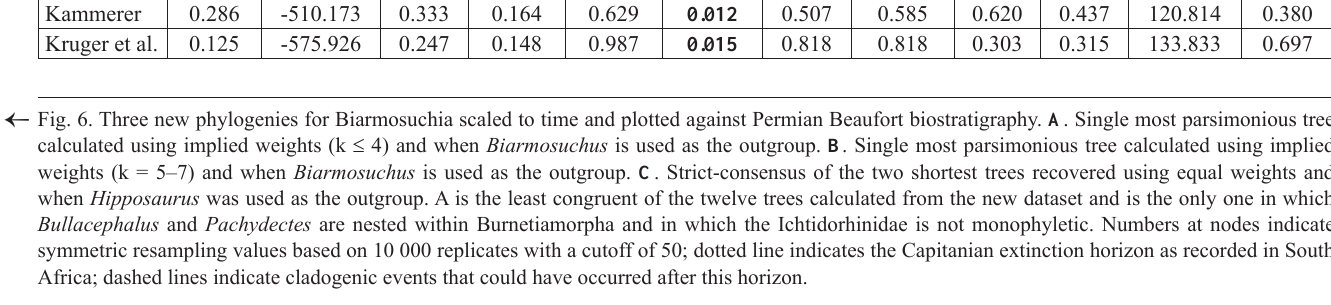
Table 1. Comparison of stratigraphic congruence metrics for trees shown in Fig. 6 (new trees A–C) and Fig. 7. P-values for individual metrics calculated from 1000 randomly constructed trees bearing the same end taxa. The new trees are better fitted to stratigraphy for all metrics and are the only one sig- nificantly different from random for the GER and MSM*. Bold indicates that a stratigraphic congruence metric is significantly different from random at p = 0.05 or p = 0.01. Abbreviations: GER, gap excess ratio; GER*, modified GER; GERt, topological GER; MIG, minimum implied gap; MSM, manhat- ten stratigraphic measure; MSM*, modified MSM; RCI, relative consistency index; SCI, stratigraphic consistency index; p.Wills, probability as calculated by the position of the MIG for the tree in question compared to the MIG of random topologies (see Bell and Lloyd 2015). Metric Estiamted p-value Metric Tree p.Wills New Tree